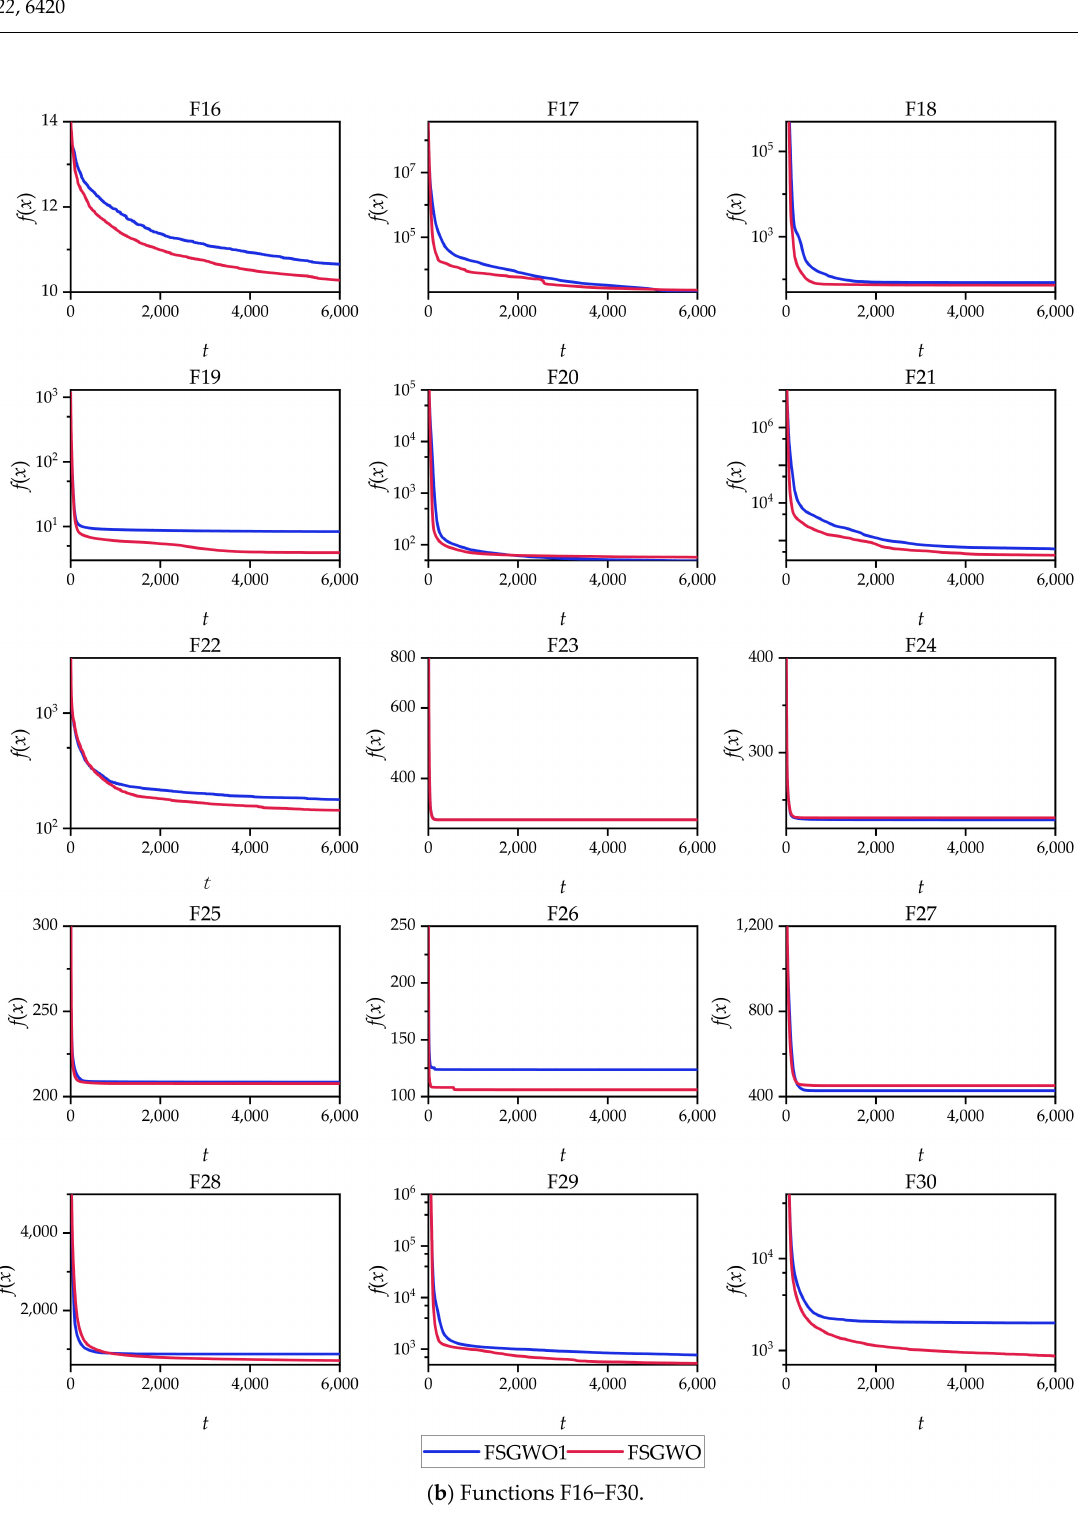
Figure 5. Convergence curves of FSGWO and